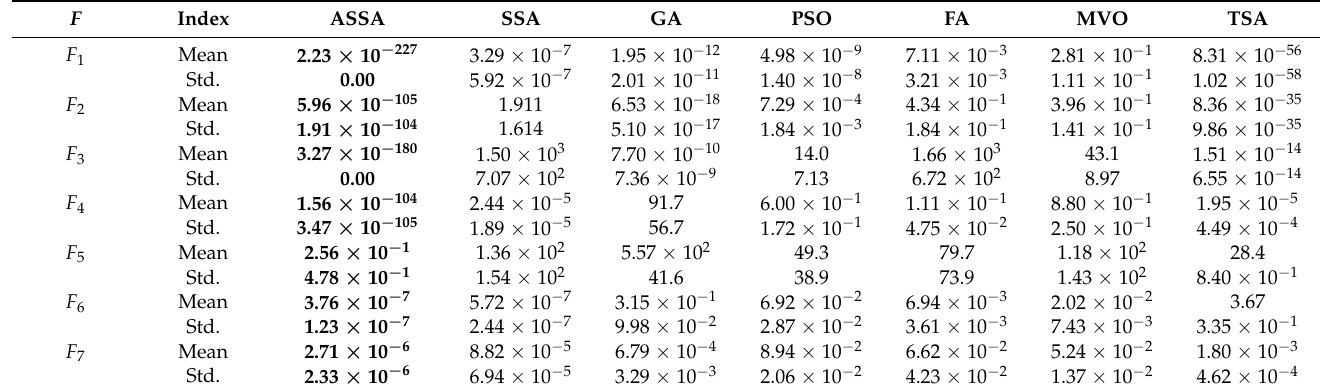
Table 4. Comparison of different methods in solving unimodal test functions.